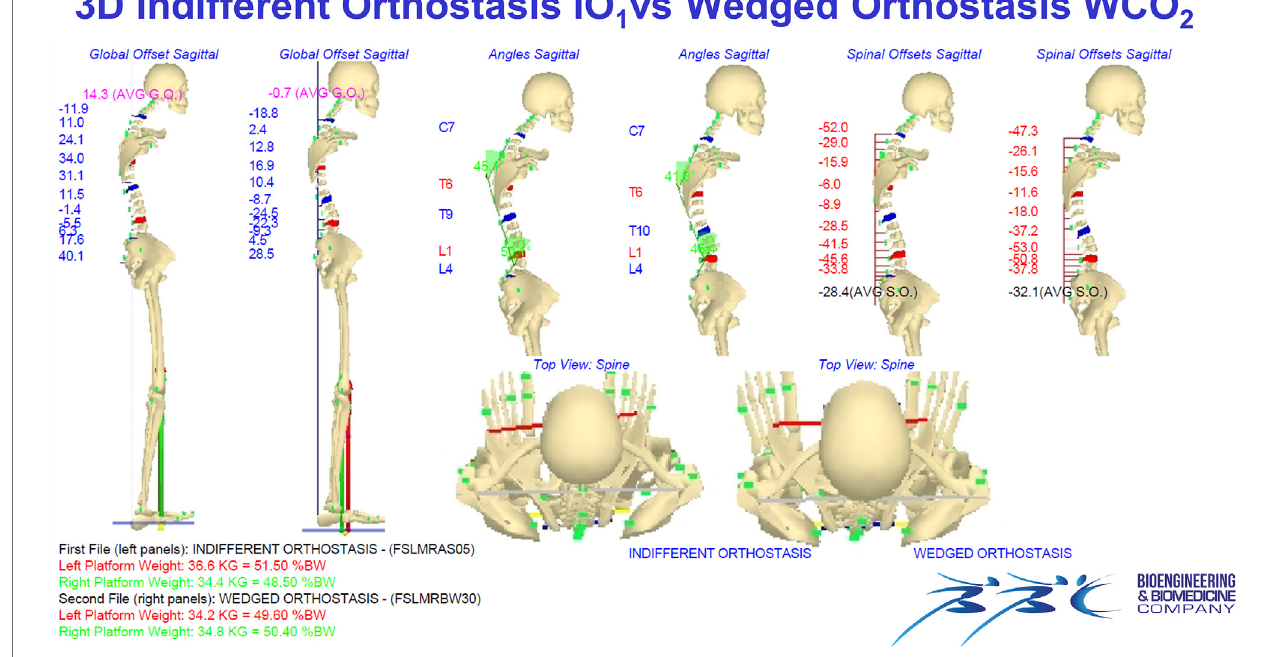
FIGURE 3 | Example of data elaboration outcome and the related graphical report of the IO 1 vs. WCO 2 measurement comparison in the frontal ( Figure 2 ) and sagittal (Panel 3) planes. IO 1 (IO at fi rst evaluation); WCO 2 (WCO at control session).